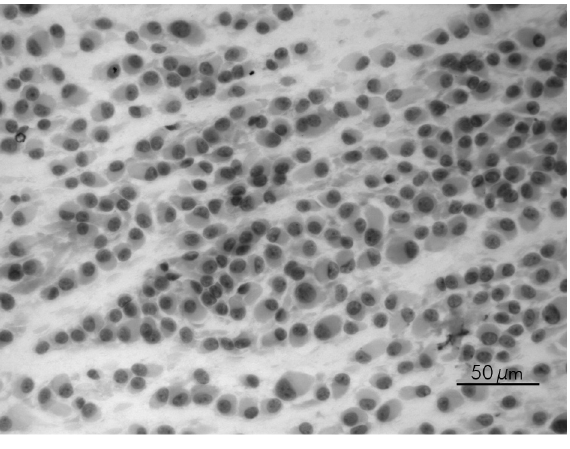
Figure 2. Presence of plasmocitoid cells on the smears with a sugestive report of Pleomorfic Adenoma (Papanicolaou